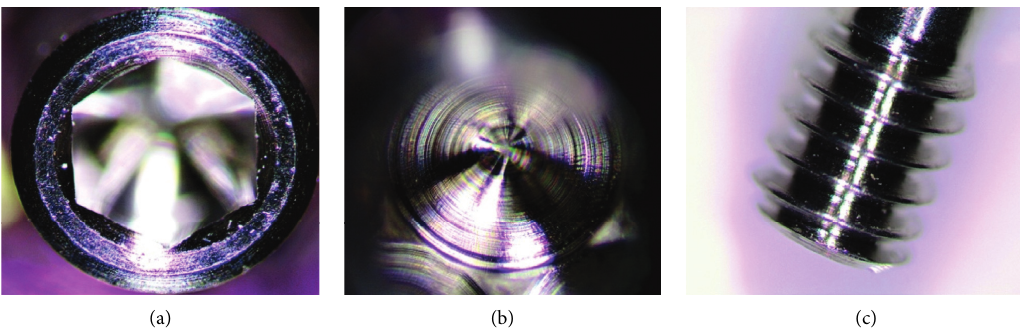
Figure 6: MIS ® screw magnification analysis: (a) screw head, (b) inside screw connection, and (c) screw thread region.